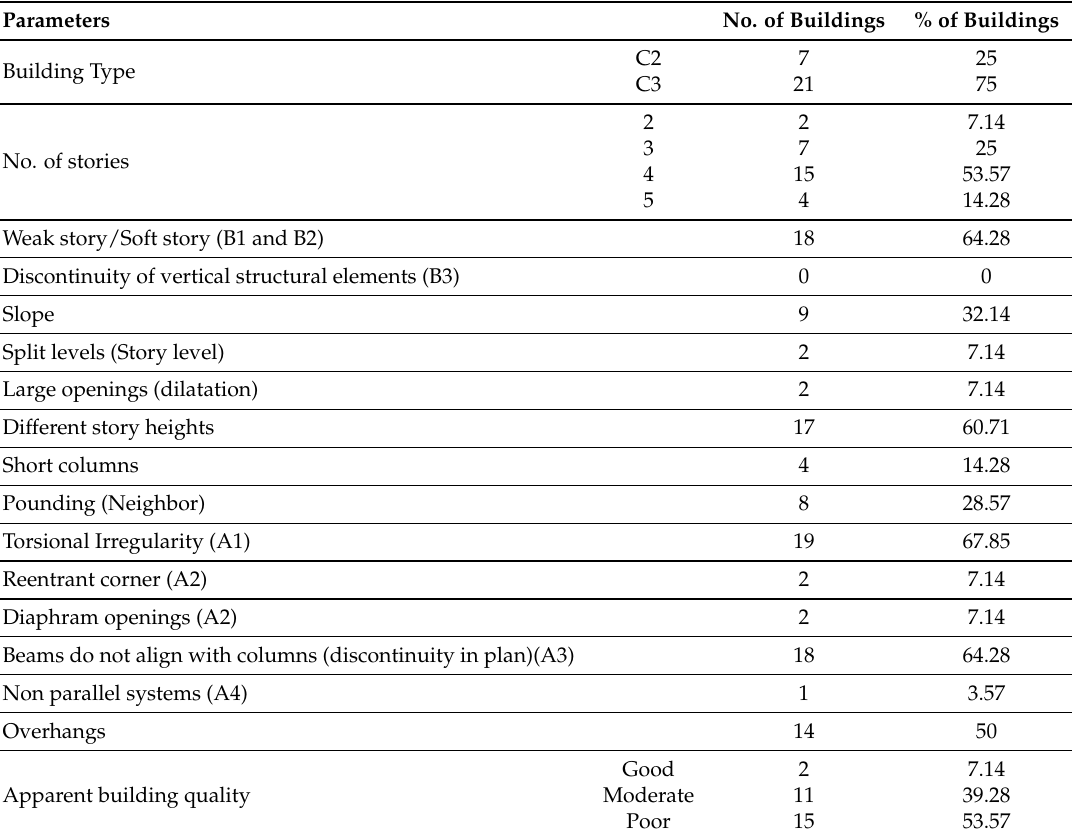
Table 9. Distribution of parameters of the building